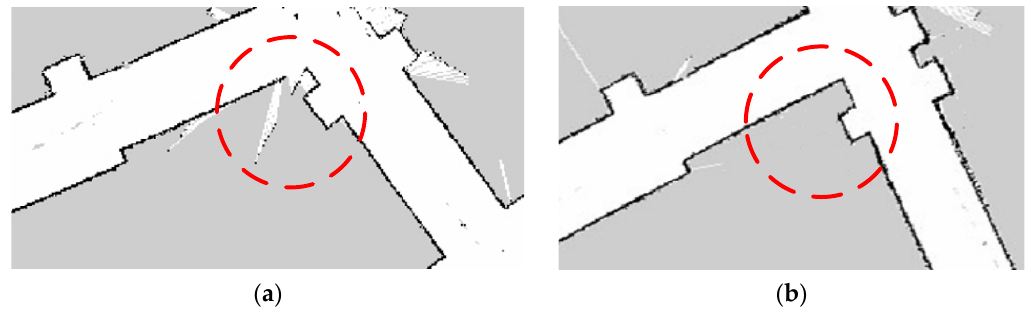
Figure 12. Map construction for turning right angle corridors before ( a ) and after ( b ) the calibration.